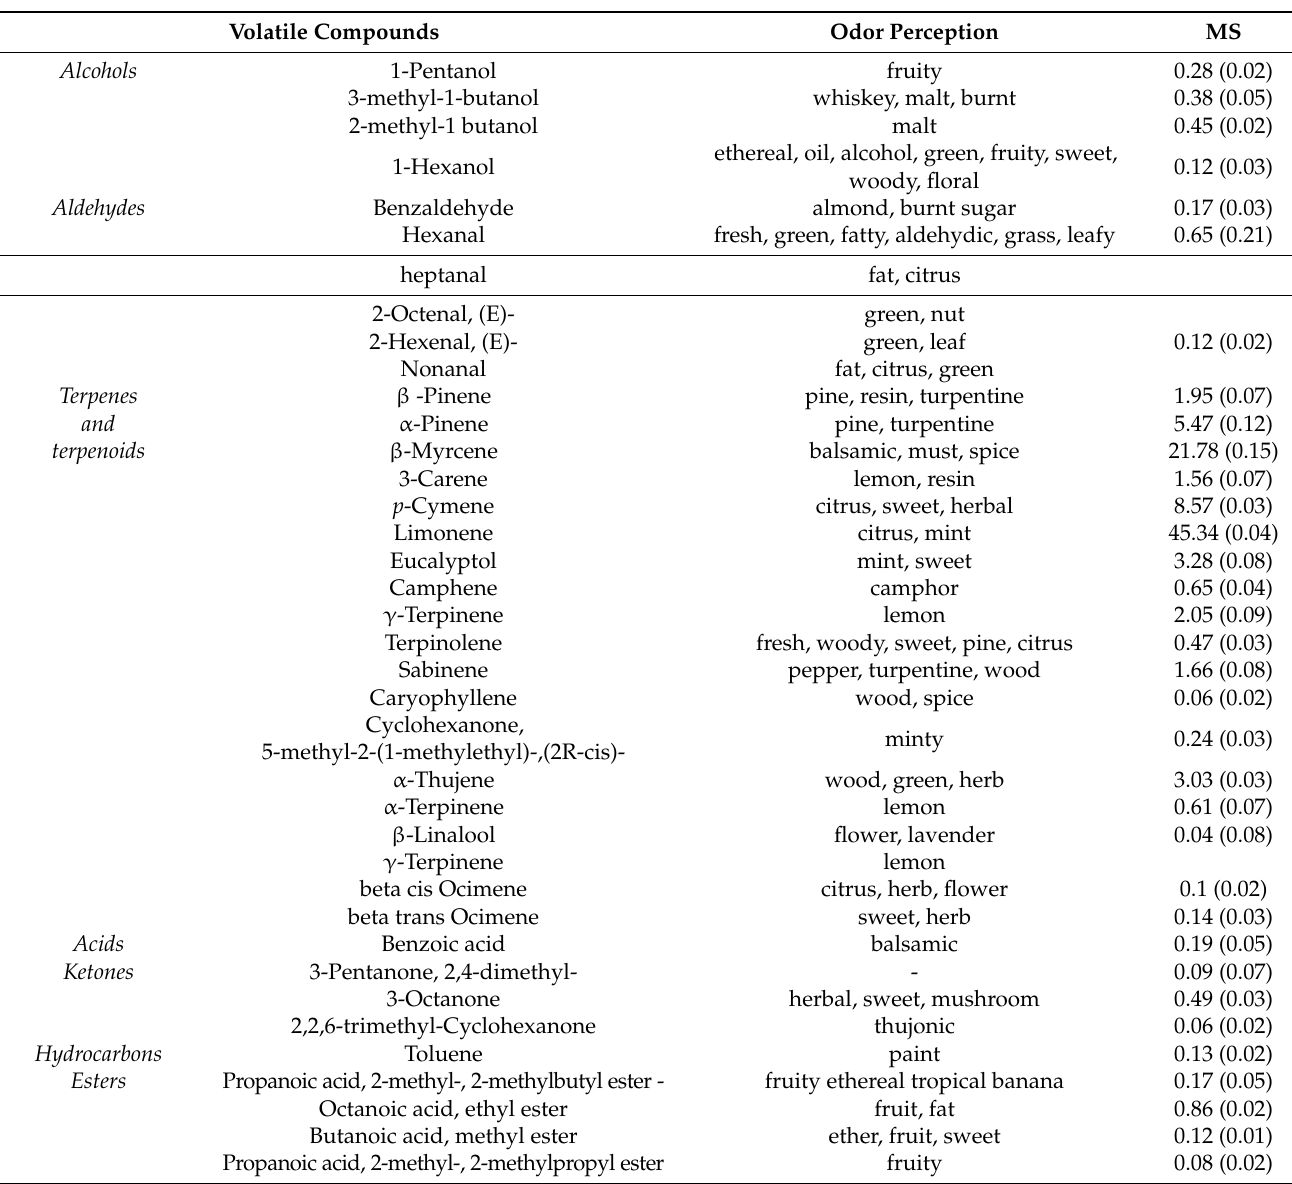
Table 6. Mean values (and standard deviation) of total peak area percentage of MS aroma compounds. All data represent the mean of three